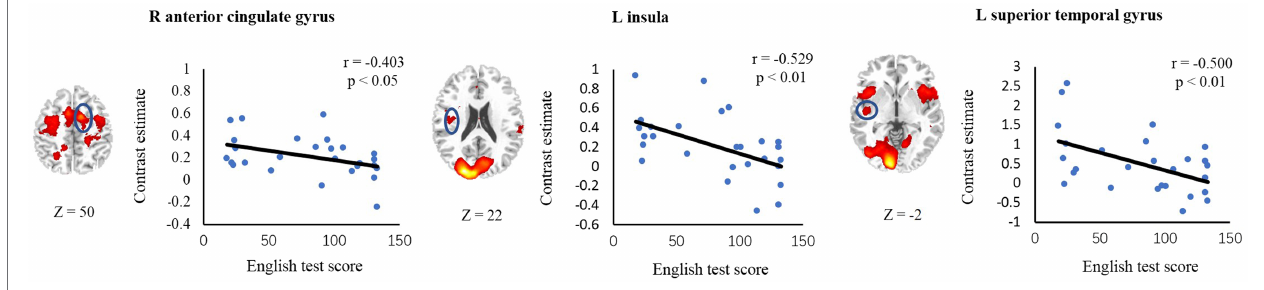
FIGURE 4 | Correlations between brain activity and L2 reading scores. Axial sections and scatter plots for ROIs (in blue circles) showing significant negative correlation are